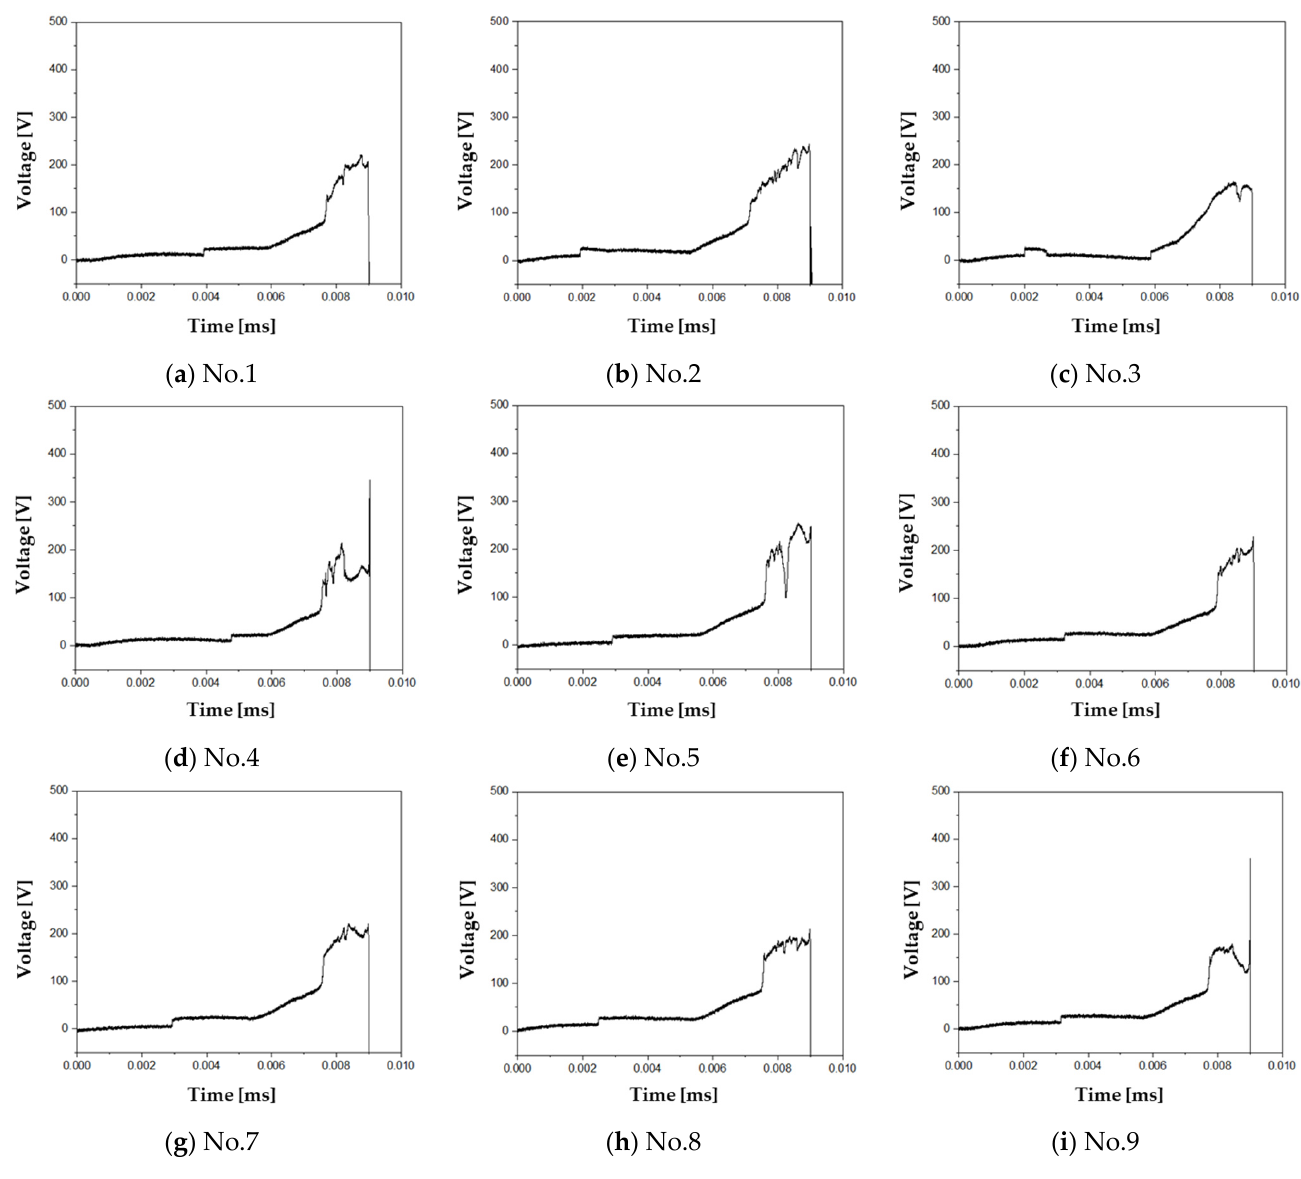
Figure 15. Short-circuit characteristics under disturbing magnetic fields. Table 4. Short-circuit characteristics test results according to disturbing magnetic fields.